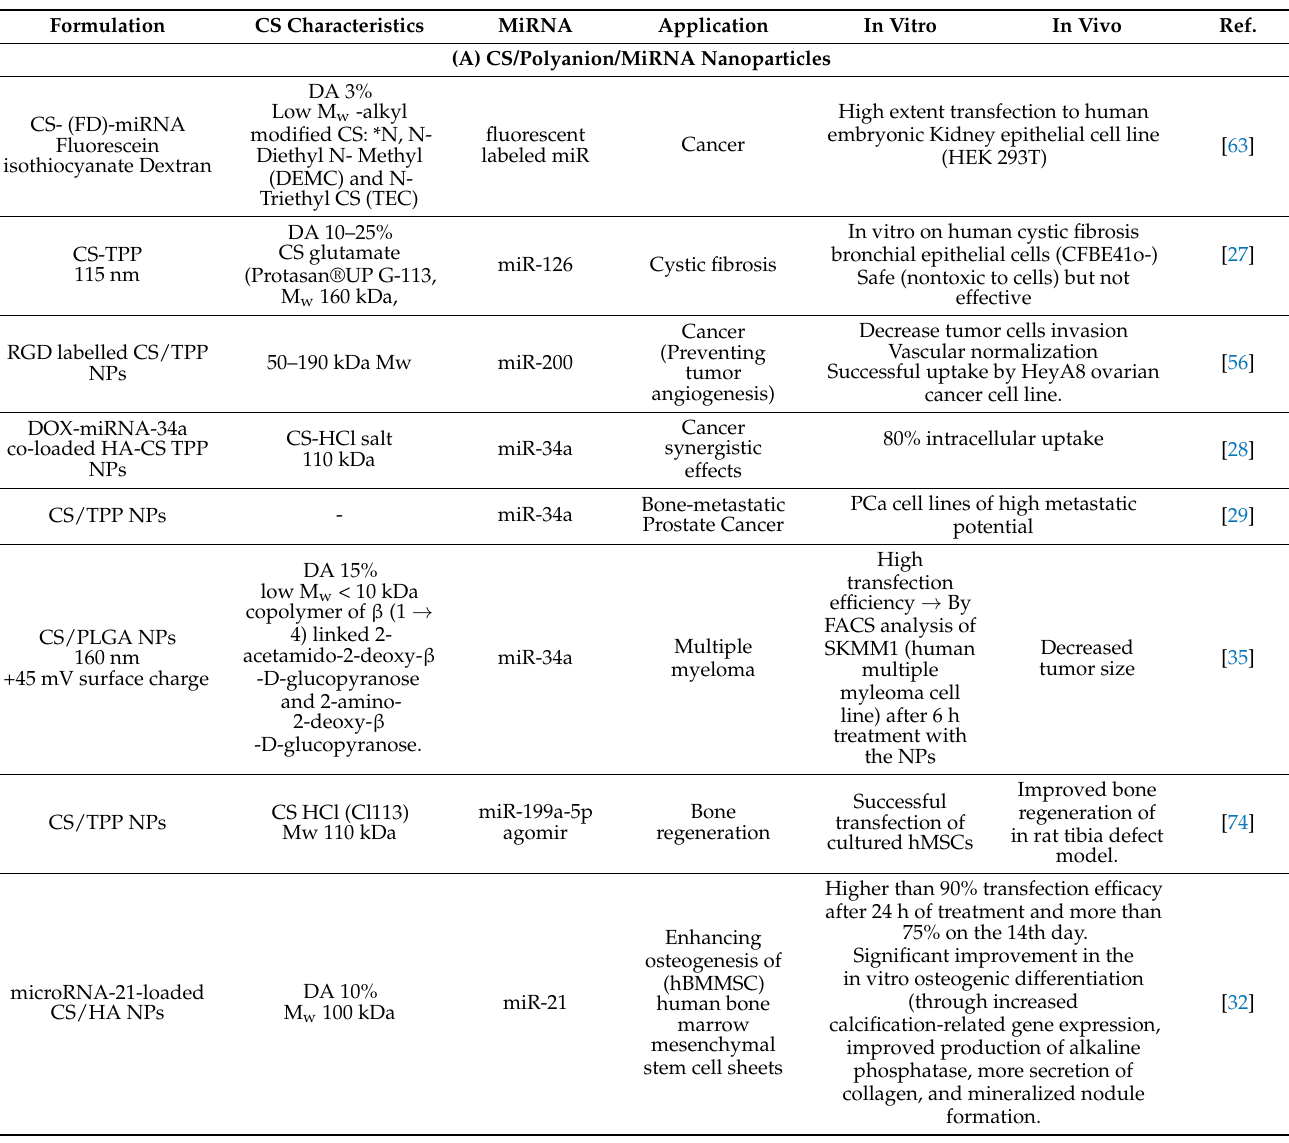
Table 3. Different CS miRNA NPs, their therapeutic applications, and in vitro and in vivo tests performed for their